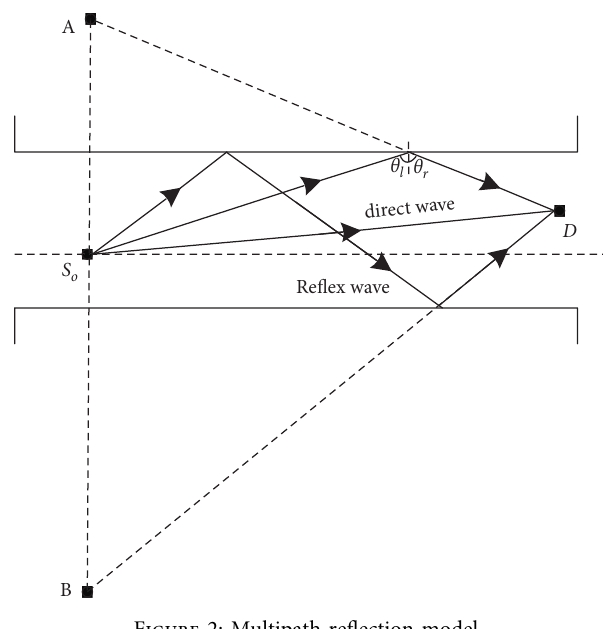
Figure 2: Multipath reflection